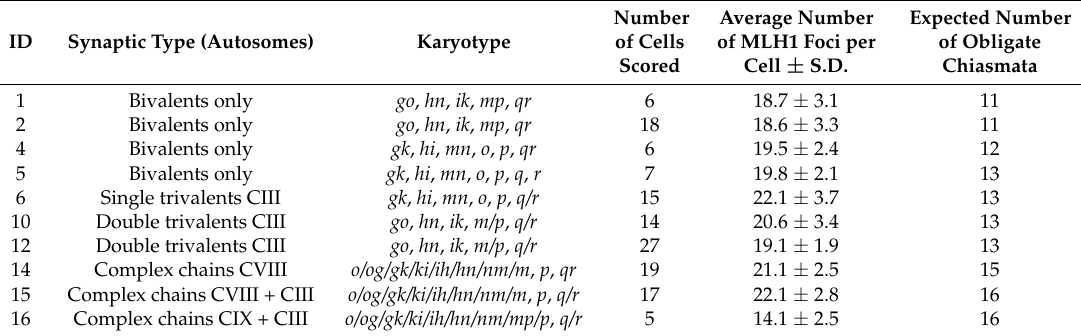
Table 2. Average number of MLH1 foci per cell (scored in the cells without synaptic abnormalities) and expected number of obligate chiasmata in the shrews of different